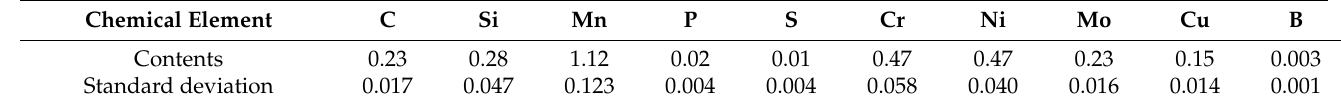
Table 1. Average chemical composition of tested steel from seven temperatures (wt.